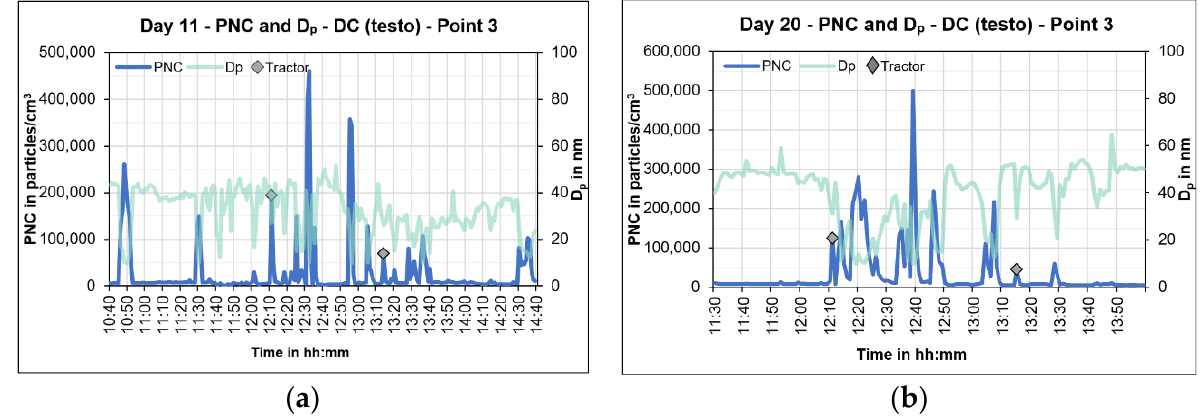
Figure 27. DC DiSCmini (testo) levels from tractors on ( a ) day 11 and ( b ) day 20.